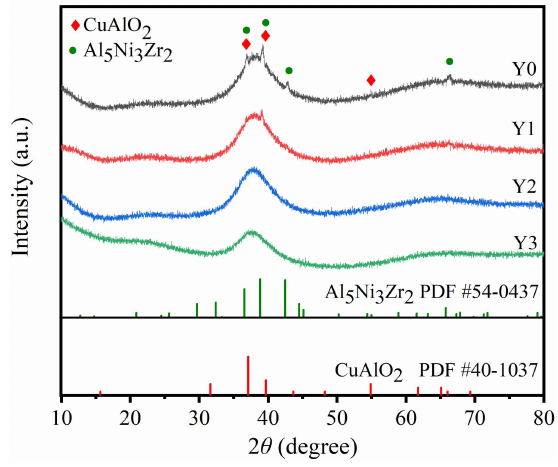
Figure 2. XRD spectra of the Y0, Y1, Y2 and Y3 specimens with ϕ 6 mm.